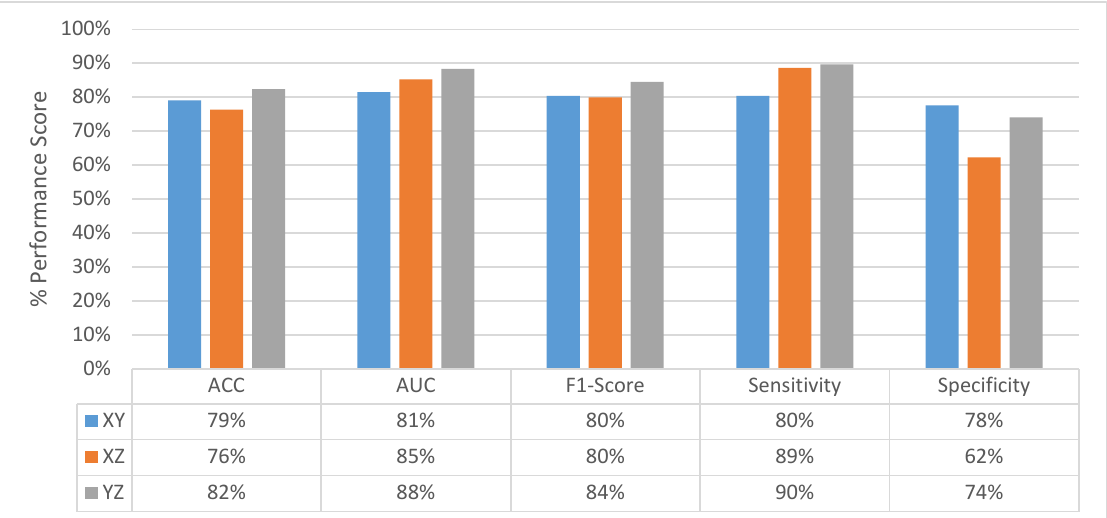
Figure 14. MPF model—change in perspective-level classification performances across different perspectives.